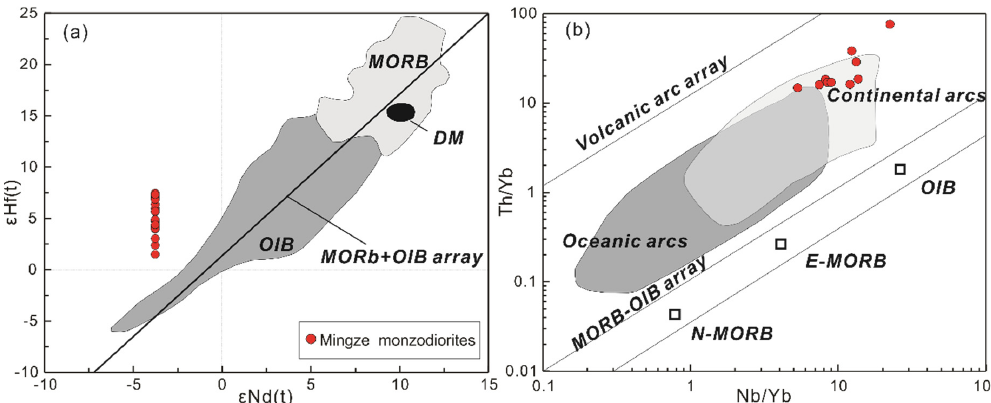
Figure 10. ( a ) ε Nd(t) versus ε Hf(t) (modify after [56]) and ( b ) Th/Yb ratio versus Nb/Yb ratio(modify after [45]) discrimination diagram for Mingze monzodiorites. MORB (mid-ocean ridge basalt) + OIB (ocean island basalt) array and fields for DM (depleted mantle), MORB and OIB are from [57].